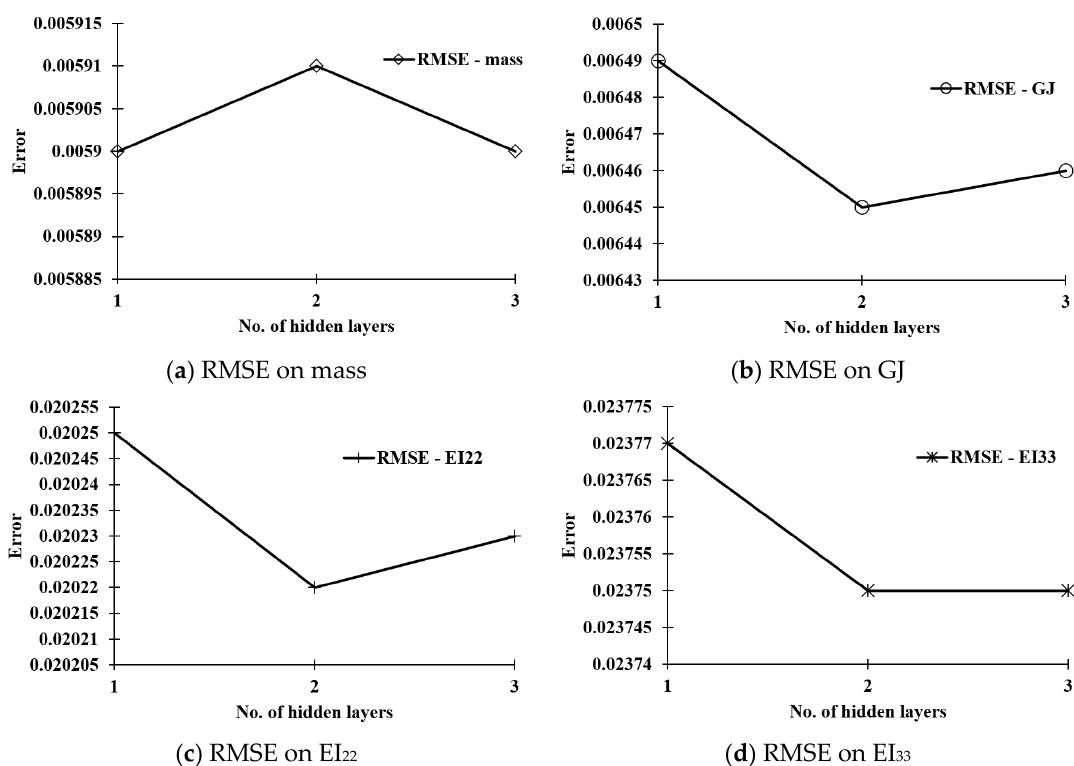
Figure 18. RMSE according to variation of hidden layer.